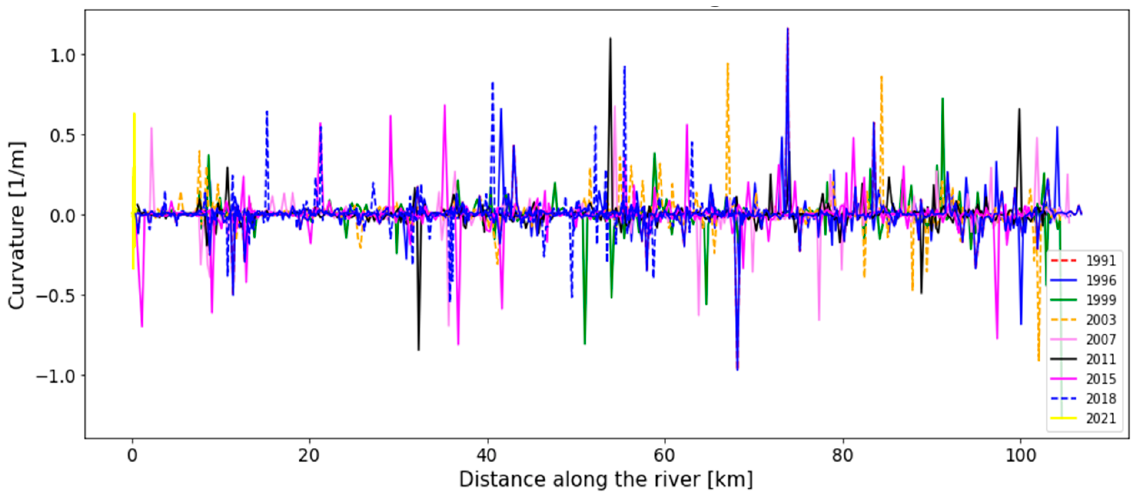
Figure 8. Spatial and temporal variation of river